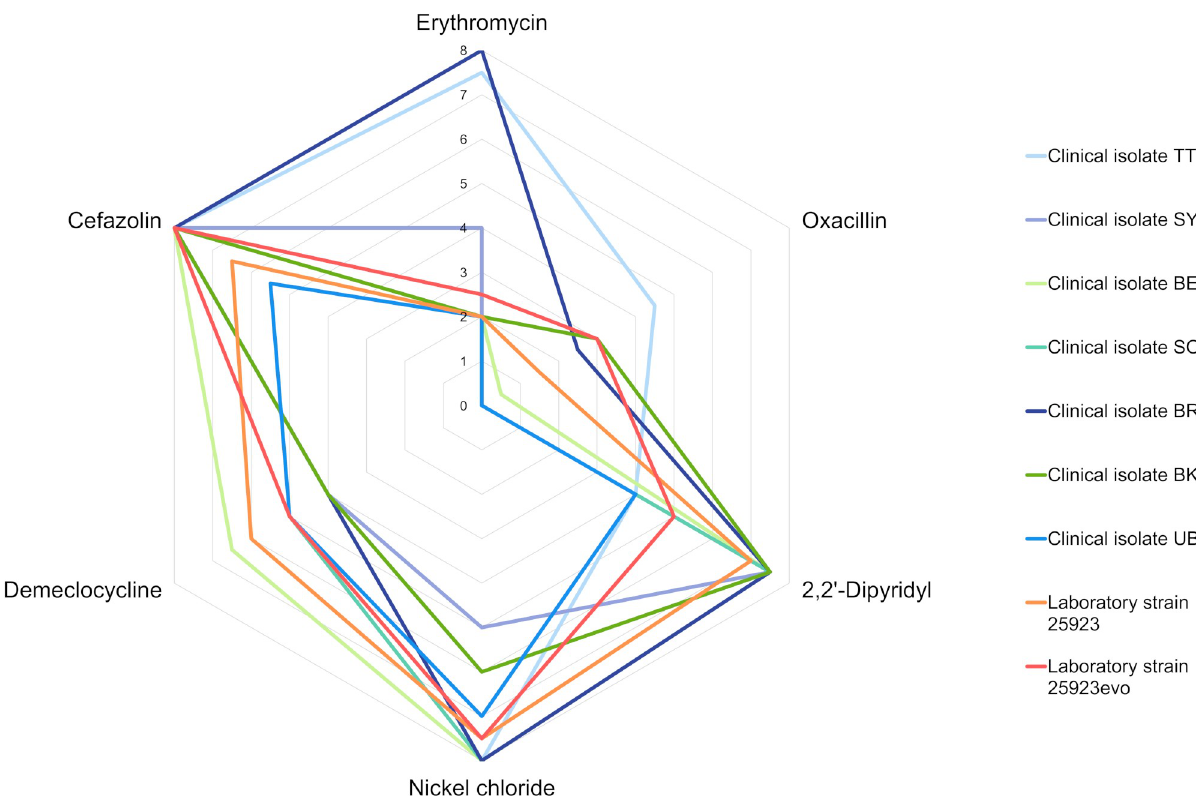
Fig 3. Phenotype Microarray growth scores for nine S . aureus strains in the presence of six different antimicrobials. The radial axis depicts the average growth score from independent duplicates. The growth scores of the seven clinical isolates are plotted in shades of blue and green. Data for the laboratory strain S . aureus ATCC 25923 and its evolved descendent, 25923evo, are plotted in orange and